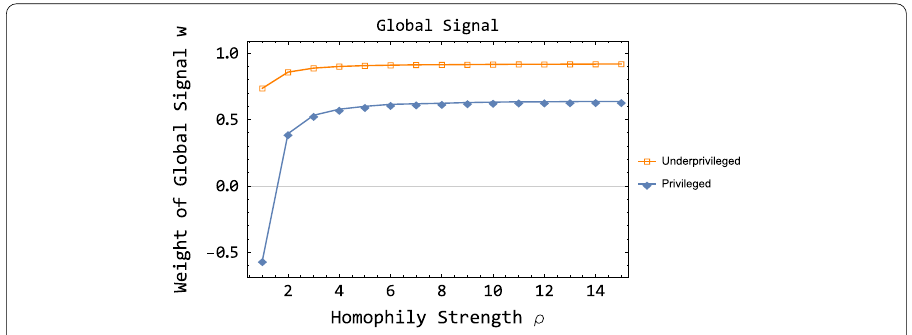
Fig. 6 Implied weights for the global signal for both privilege classes and the empirical